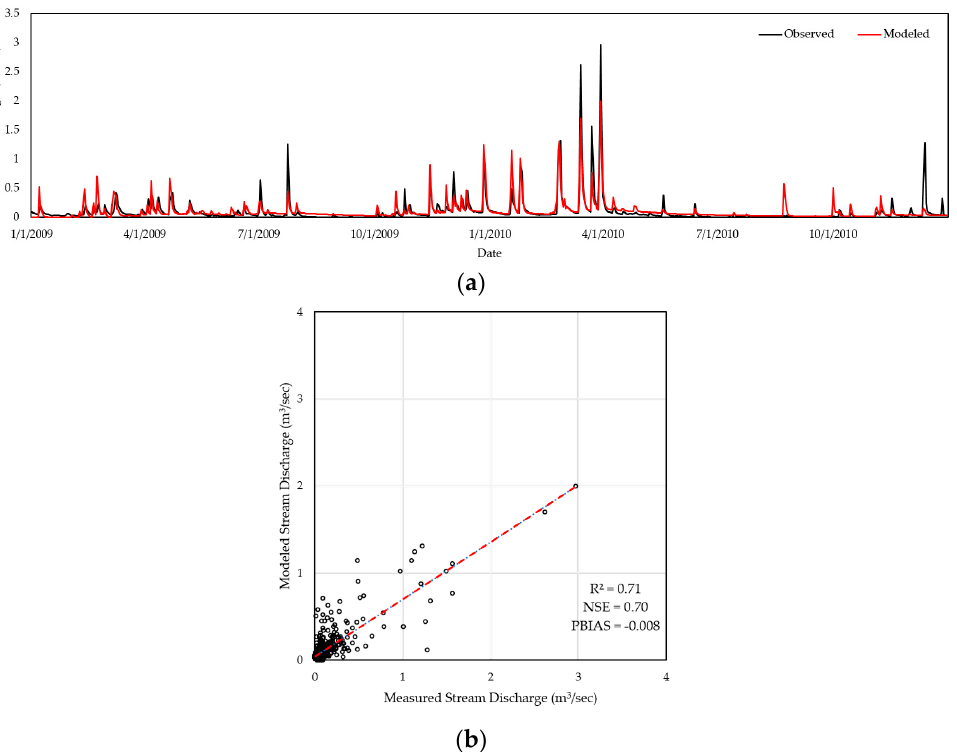
Figure 4. ( a ) Hydrograph and ( b ) scatterplot of observed versus SWAT modeled streamflow at Cork Brook USGS gauge 01115280 during calibration years 2009–2010. Table 1. Statistical results of daily streamflow calibration produced by SWAT-CUP.